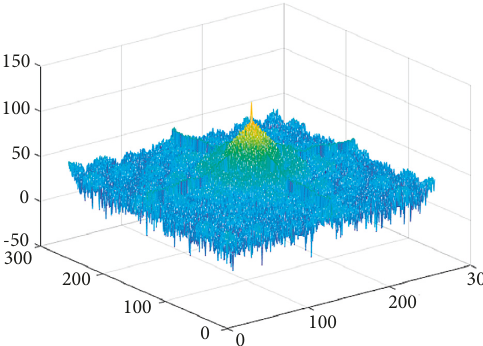
Figure 6: Mesh grid PSD estimate.